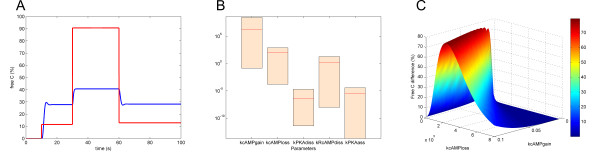
Deterministic model of the PKA module. (A) Simulation of PKA Model A (blue trace) and PKA Model B (red trace). The cAMP level is 0 initially, and is increased to 270900 molecules per cell (equivalent to 0.015 mM) after 10 seconds, increased to 909000 molecules per cell after 30 seconds, and decreased to 270900 molecules per cell after 60 seconds. (B) Steady state parameter sensitivity analysis carried out on the PKA module. (C) Parameter scan of PKA Model A. The greatest value for PKA difference (79.1%) is achieved when kcAMPgain = 0.1, kcAMPloss = 2.2 × 105, kPKAdiss = 1 × 105, kRcAMPdiss = 100, kPKAass = 1000.